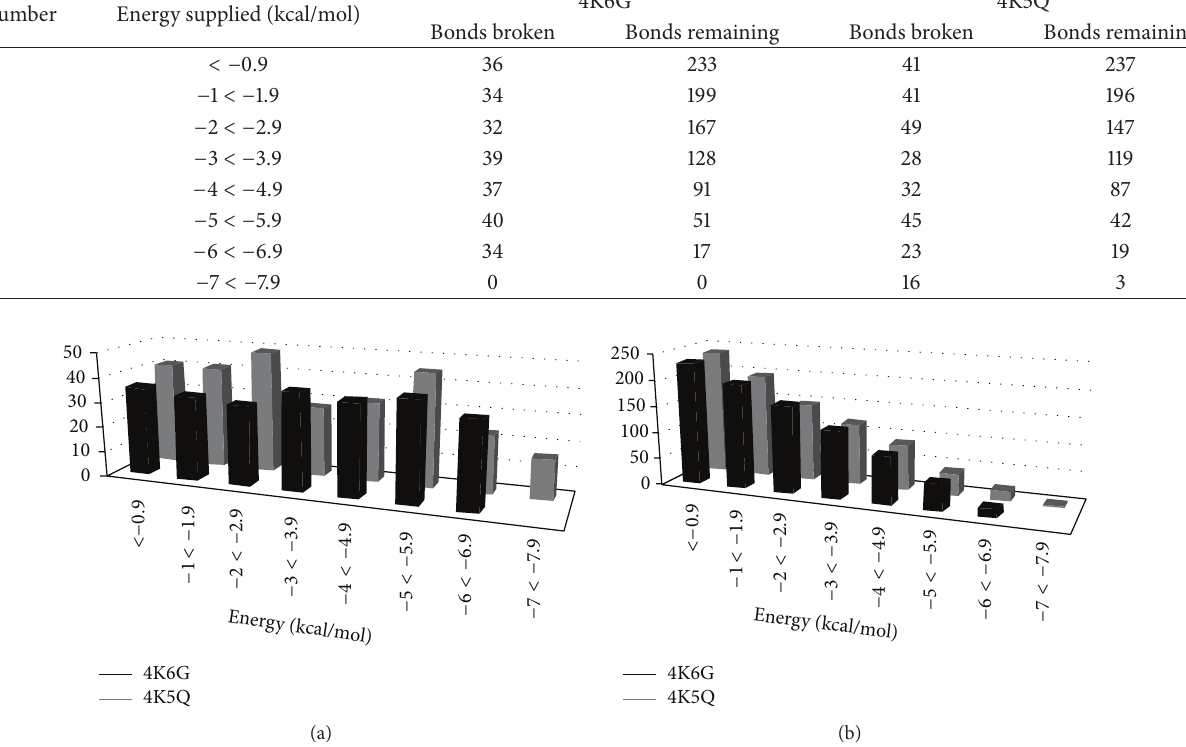
Figure 3: Comparative graphical representation of (a) the number of hydrogen bonds broken and (b) the number of hydrogen bonds remaining to be broken, at different energy levels for native (4K6G) CALB and mutant (4K5Q)